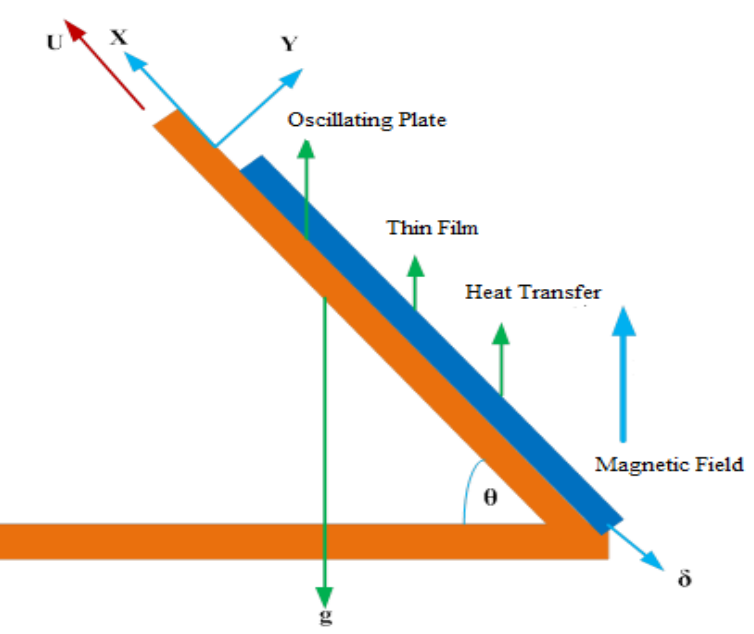
Figure 1. The physical configuration of the problem considering thin film flow of the Williamson fluid passing over an inclined, oscillating, and moving belt.